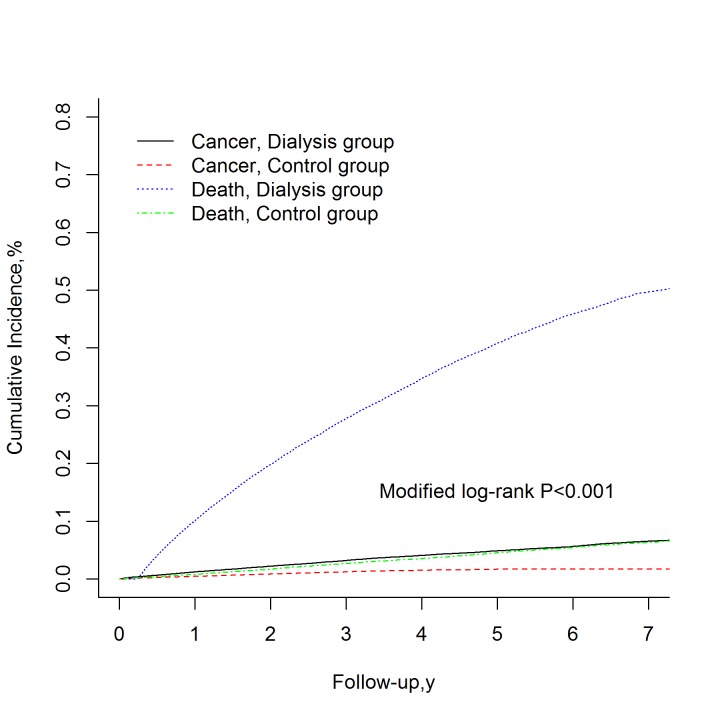
Cumulative incidence for cancer and mortality.Data were compiled after consideration for competing mortality. The cumulative rate between dialysis and control group were calculated using Modified Kaplan-Meier and Gray methods [30] and test their difference between groups by modified log-rank test. The Modified log-rank P value for comparing the cumulative incidence for cancer in dialysis and control group is less than 0.001.